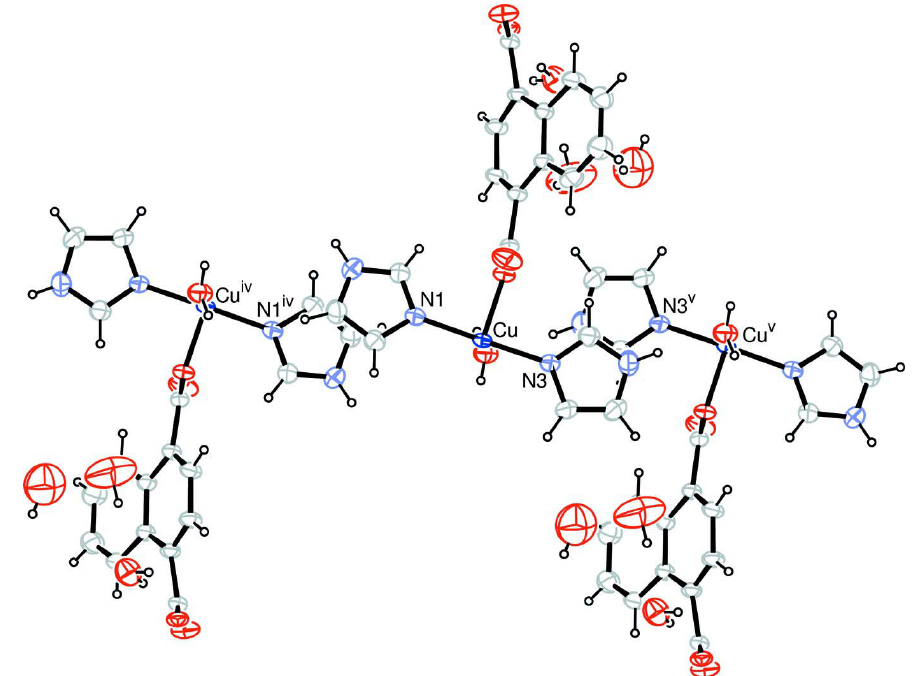
Figure 3 A diagram showing the contacts between imidazole rings [symmetry codes: (iv) 1 - x , - y , 1 - z ; (v) 1 - x , 1 - y , 1 - z ]. catena -Poly[[[aquabis(1H-imidazole- κ N 3 )copper(II)]- µ -naphthalene-1,4-dicarboxylato- κ 2 O 1 : O 4 ]